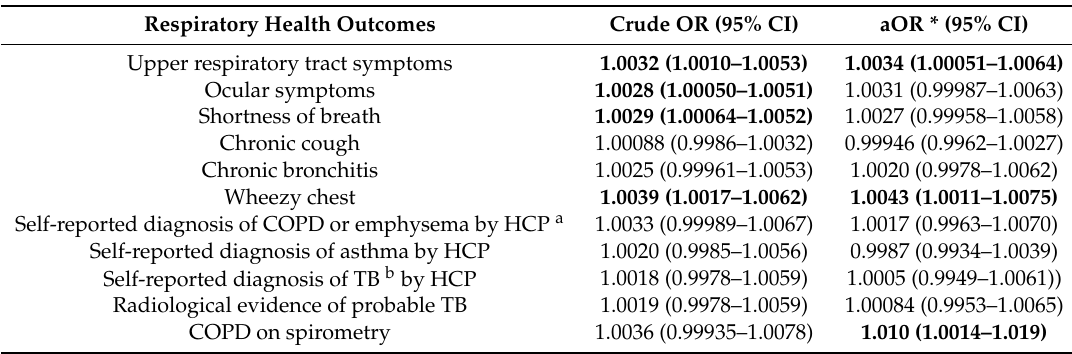
Table 5. Simple and multivariate logistic regression models of the associations between cumulative exposure intensity and respiratory health outcomes.